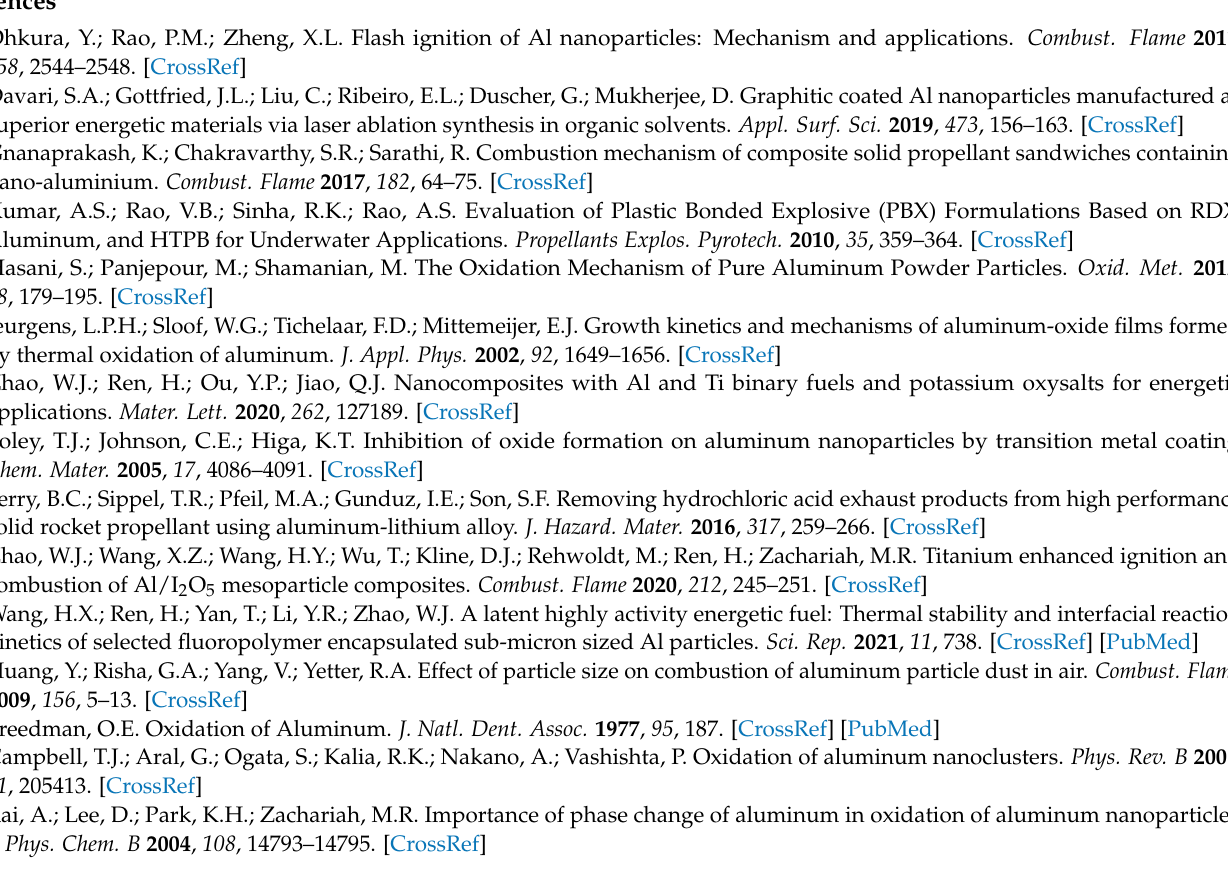
Table S2: Characteristic parameters of PFPE-functionalized Al NPs at a heating rate of 5 K · min − 1 . Table S3: Physical properties of Al and Al 2 O 3